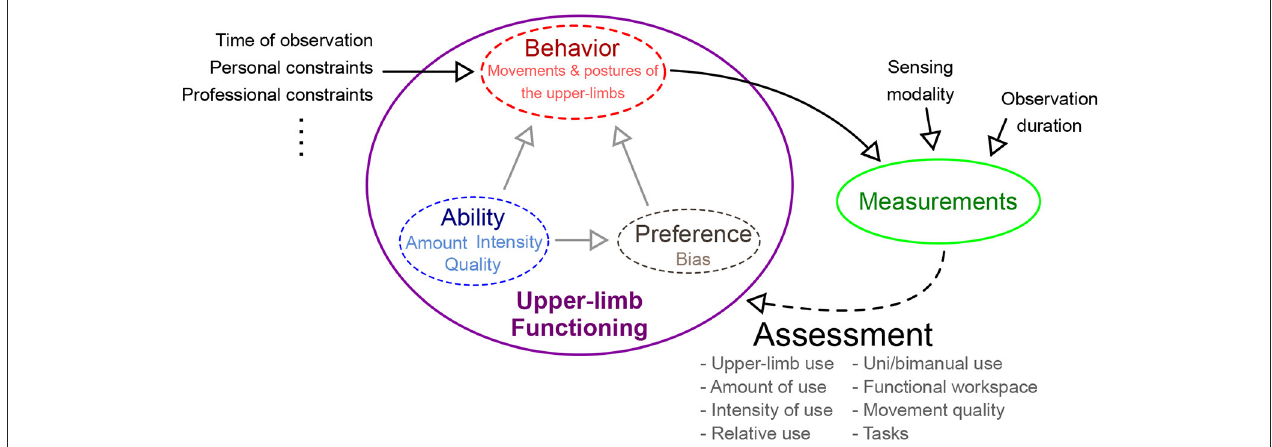
FIGURE 1 | Different factors affecting the nature of use of the two upper-limbs during daily life. The construct of upper-limb functioning is composed of one’s ability, preference, and observable behavior. Behavior is affected by multiple factors: intrinsic and extrinsic factors. Intrinsic factors inherent to a subject, e.g., ability and preference, while extrinsic factors are external to the subject. Measurements of behavior are used by an assessment procedure to estimate upper-limb functioning. confounding factors influencing behavior (e.g., desk vs.